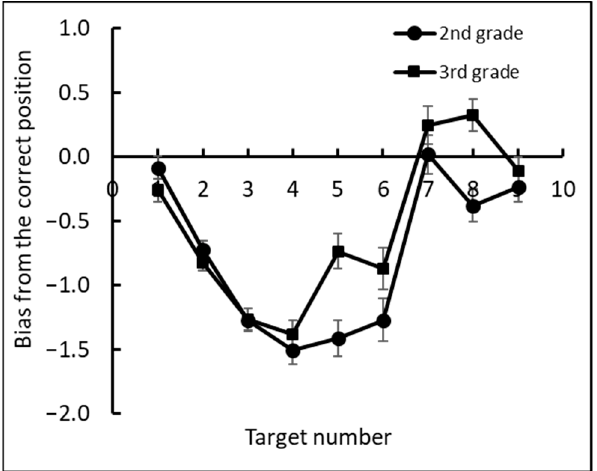
Figure 11. The mean bias value: the deviation between the estimated position of each target number and its correct position for each grade.